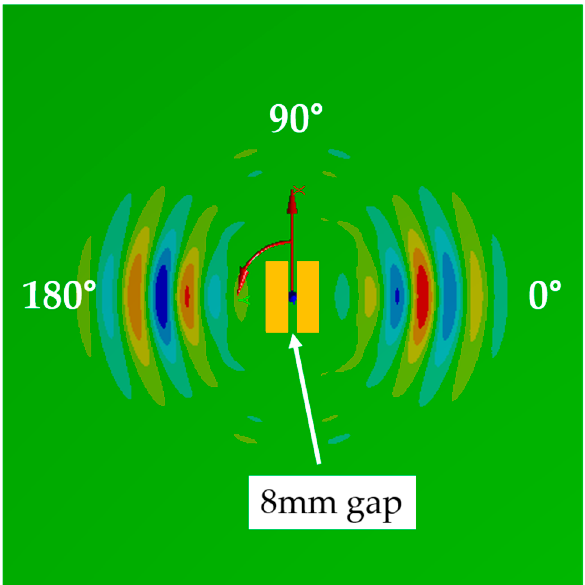
Figure 17. Result of the simulation of the dual SHPFP with an 8-mm gap. Snapshot of the tangential wave field component at 50 µ s after excitation with f c = 80 kHz .